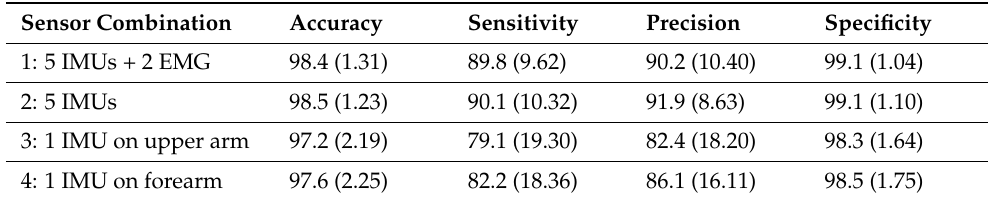
Table 3. Performance measures (in %, mean (SD)) of the trained algorithms for the four different sensor